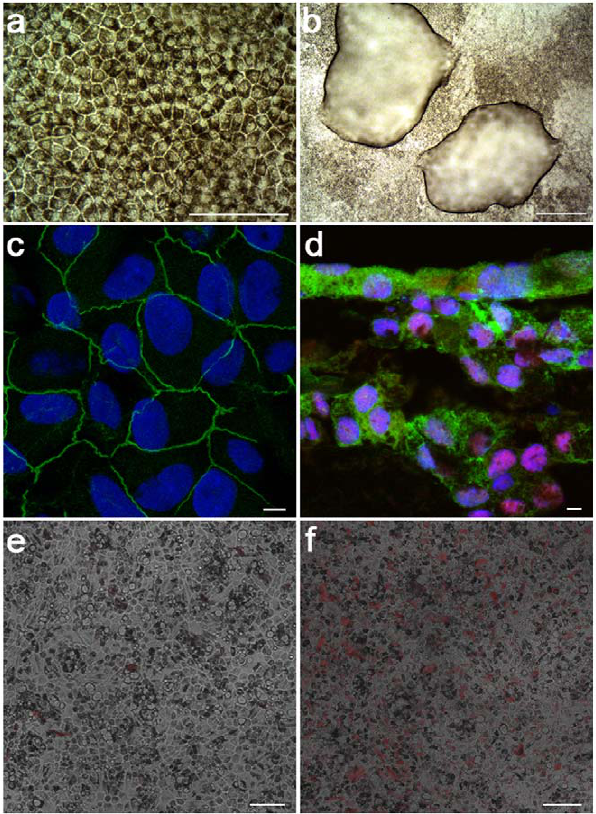
Figure 6. phESC produce functional RPE cells after differenti- ation. The LLC6P line produces pigmented cells in culture (a) and characteristic ‘‘dome-like’’ structures (b). Cells express RPE markers Occludin (c), CRALBP and mitf (d). Functionality of LLC6P-derived RPE is demonstrated by pHrhodo pH-sensitive fluorescent particle phagocy- tosis (e and d). Five minutes after administration of pHrhodo (e), RPE exhibit minimal vesicular pHrhodo content. Two hours and five minutes after administration (f), RPE exhibit marked increase in vesicular pHrhodo content. Scale bars represent 100 m m (a, e, f), 500 m m (b) and 5 m m (c, d).